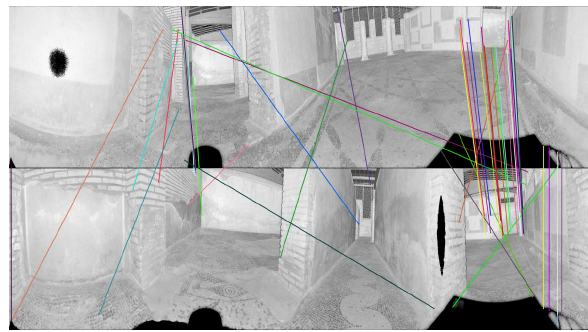
Figure 2: Illustration of a scan pair with Mercator projection and matched features from the garden house in Ostia